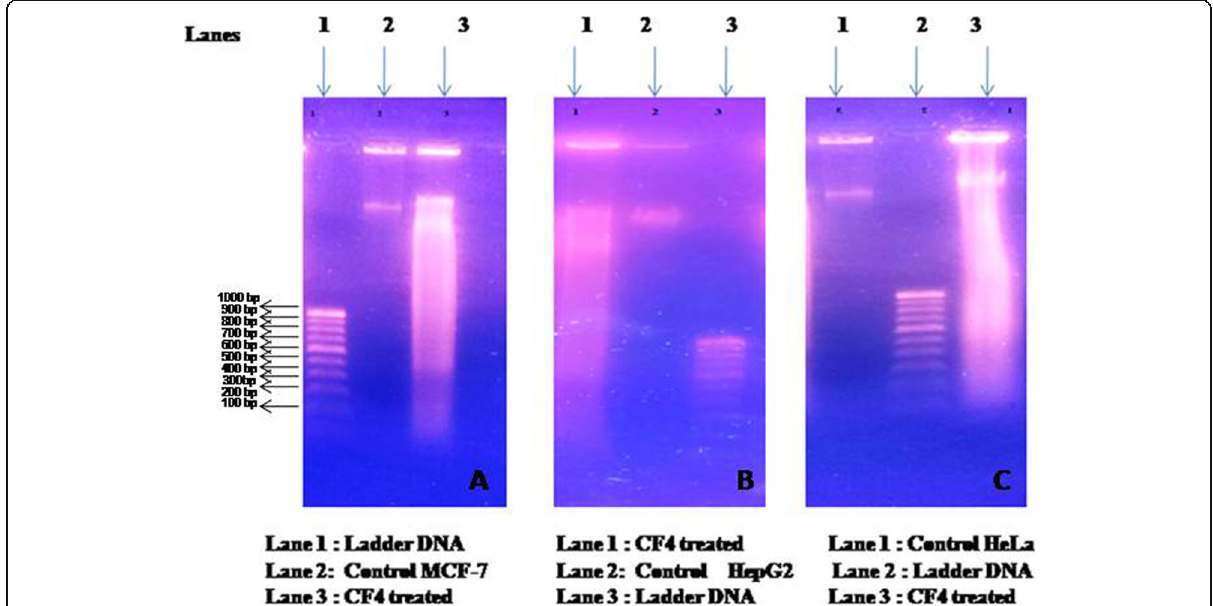
Fig. 7 Analysis of DNA fragmentation in the cancer cells. DNA from a MCF-7, b HepG2, c HeLa cells treated with CF4 on 0.8% agarose gel